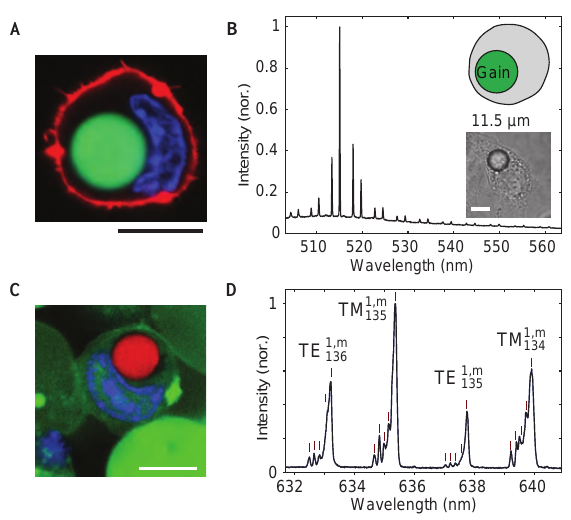
Fig. 9. Intracellular micro-lasers. (A) An intracellular laser based on a fluorescent bead. (B) Lasing emission from an 11.5-µm bead in a cell. Scale bar, 10 µm. (C) A dye-doped high-index oil droplet injected into a cell. (D) Lasing spectrum from a single oil droplet shows split spectral lines because of droplet